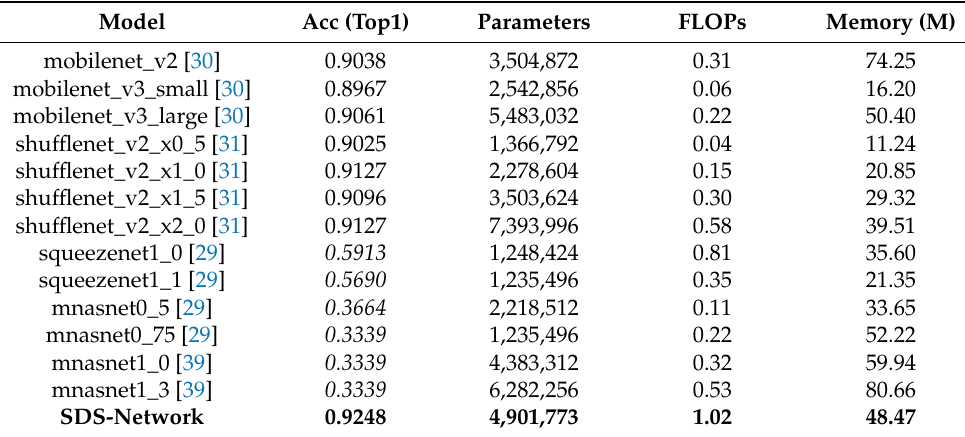
Table 6. Comparison of SDS-Network model and efficient series of algorithms.